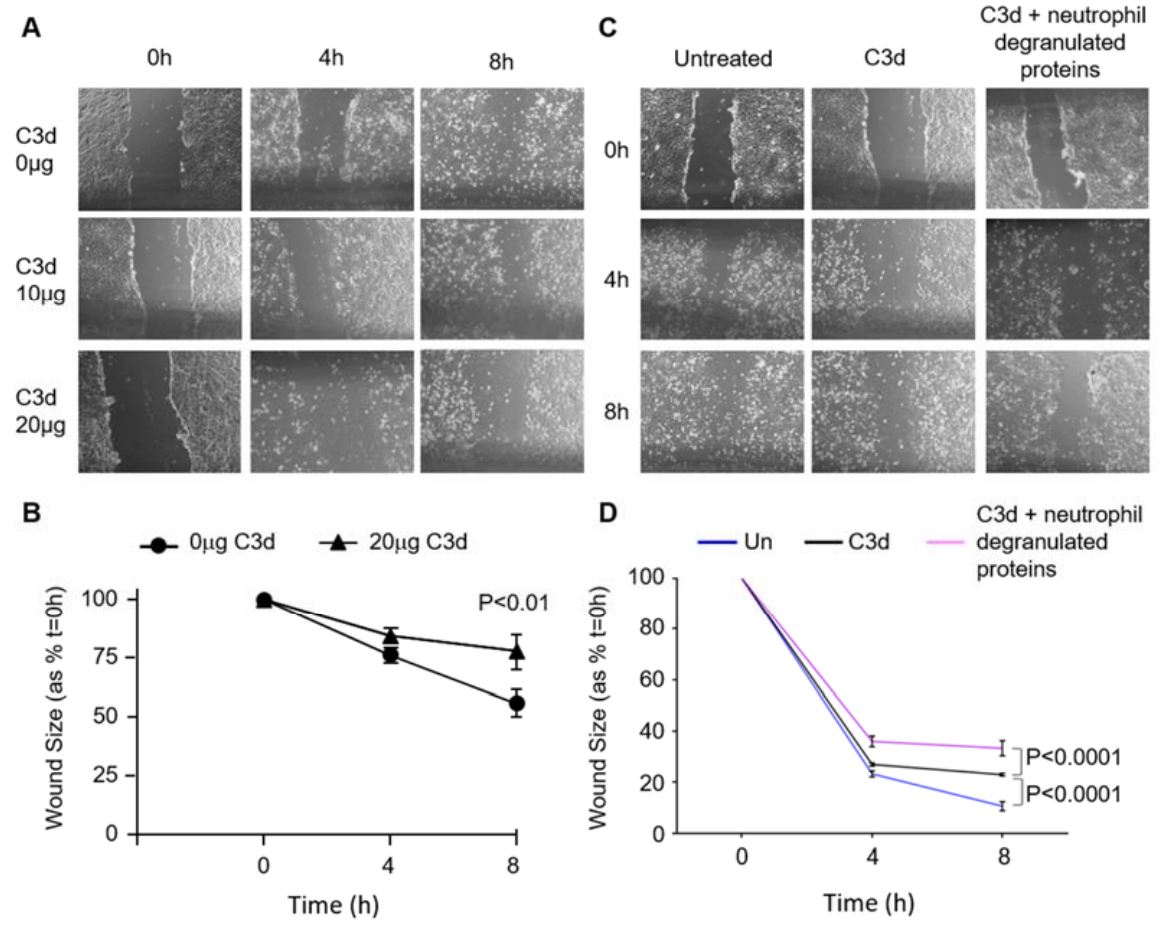
Figure 7. The effect of C3d on endothelial cell migration. ( A ) Representative images of in vitro wound healing assays of HUVECs either untreated or treated with C3d (10 or 20 µ g/mL). Microphotographs of the wounded area were taken immediately after the scratch (0 h) and 4 h or 8 h. ( B ) Wound healing rates were significantly decreased by 20 µ g/mL C3d ( p < 0.0001) ( n = 3 independent experiments). ( C ) HUVECs remained untreated or were treated with 20 µ g/mL C3d ± neutrophil degranulated proteins (10 µ g/mL MPO/lactoferrin/BPI pool). ( D ) Wound healing rates were significantly decreased in C3d ( p < 0.0001) and C3d + degranulated proteins at 8 h ( p < 0.0001) ( n = 3 independent experiments, ANOVA). Images in panels ( A , C ) were taken at 20 ×